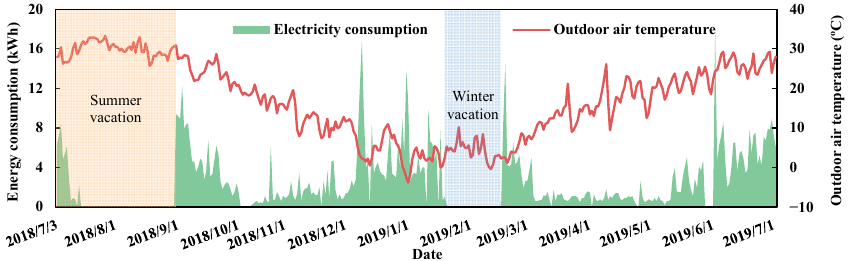
Figure 7. Raw energy consumption data of a typical dormitory and outdoor air temperature.